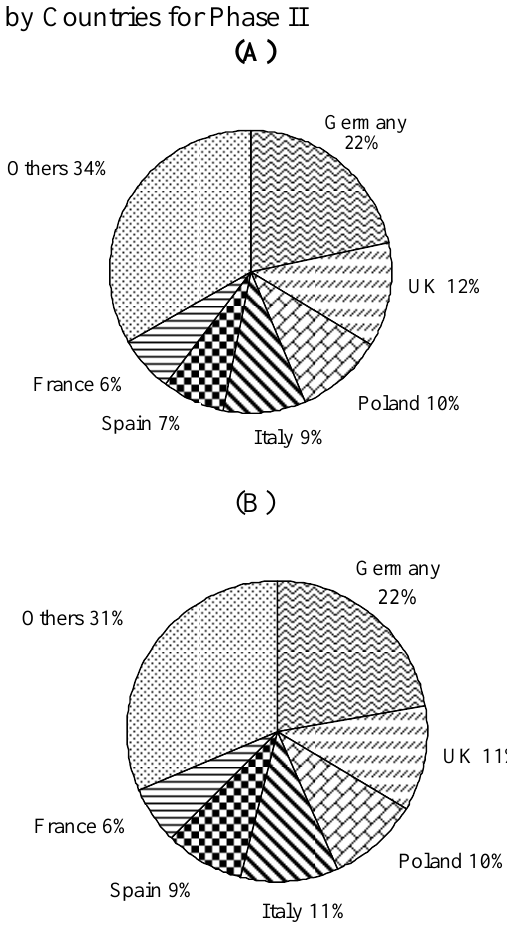
Figure 3. Percentages of the Allocations of Large European Countries. ( A). Percentages of Total Allowances Distribution by Countries for Phase I. (B) Percentages of Total Allowances Distribution by Countries for Phase II (A)